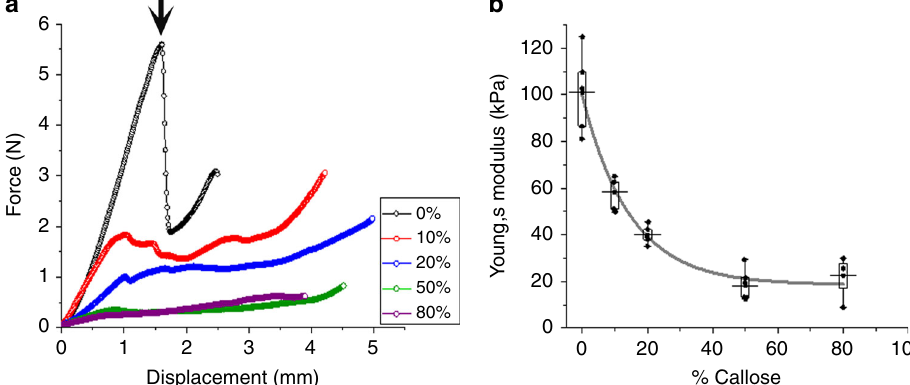
Fig. 3 Mechanical properties of cellulose-callose hydrogels. a shows force-displacement curves obtained for the hydrogels at different callose concentrations (0% in black, 10% in red, 20% in blue, 50% in green and 80% in magenta) using a Texture Analyser and a 2 mm fl at-ended probe in compression mode. The yield point for 100% cellulose (0% callose), which coincides with a yield stress of 1.4 MPa, is arrowed. b shows Young ’ s modulus values as a function of callose concentration represented in a box plot. The solid line is drawn to guide the eye. The Young ’ s modulus was calculated according to the Sneddon model as described in methods. Boxes represent the fi rst (25%) and third (75%) quartiles, the central horizontal line is the mean, and outliers at the 1% and 99% level are indicated by the whiskers. Individual data correspond to four- fi ve independent